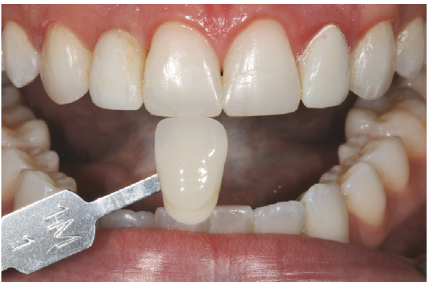
Figure 6: After recontouring with composite resin (Amaris) and provisional restoration with bisacrylic resin (Structur 3), the ceramic color was selected from the VITA 3D Master